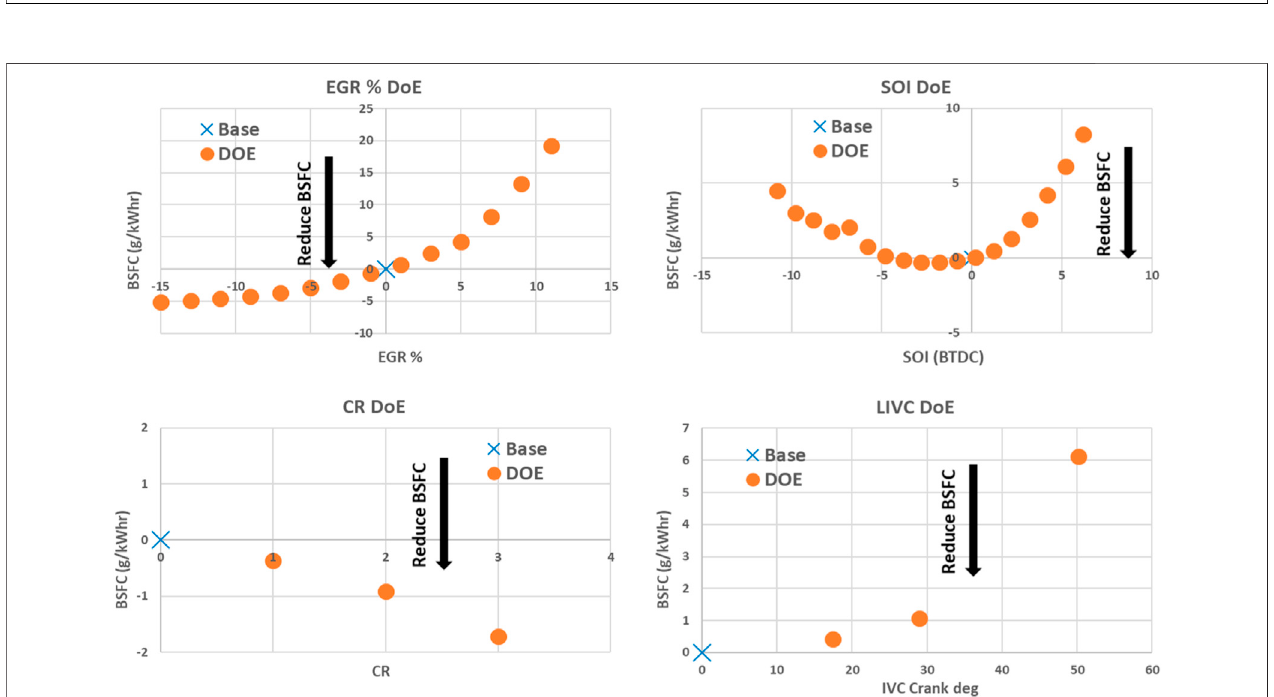
FIGURE 18 | Key parameter DOE for optimized